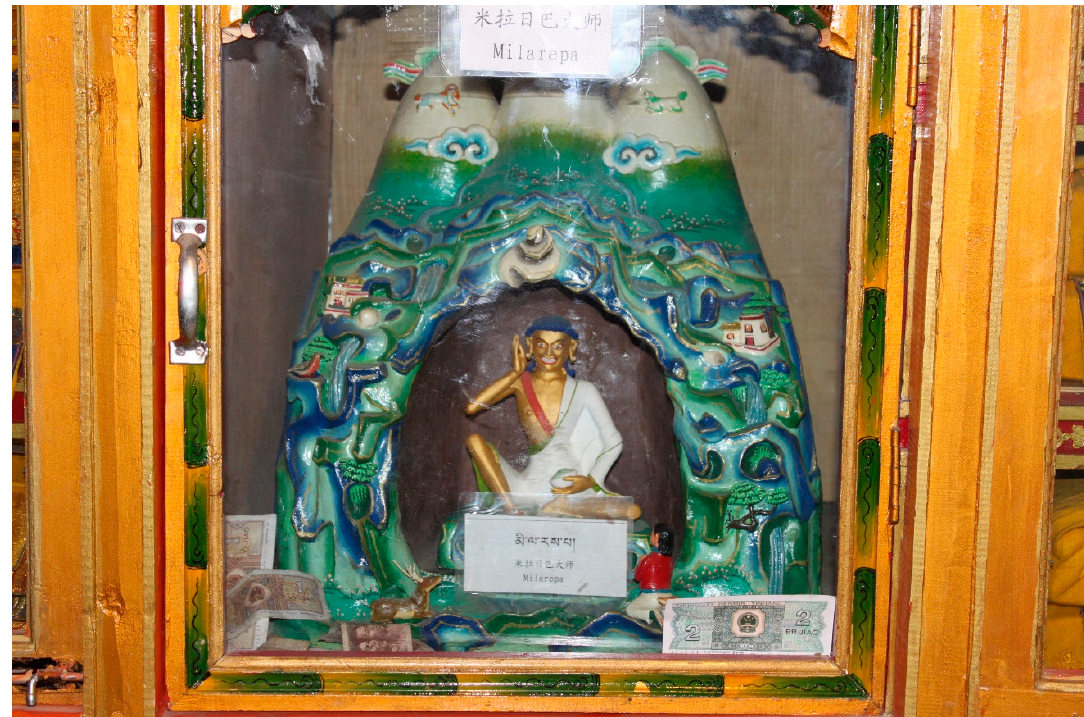
Figure 12. The saint and poet Milarepa, 20th century, clay, Drepung Monastery, Tibet (photo C. Bellini 2012).